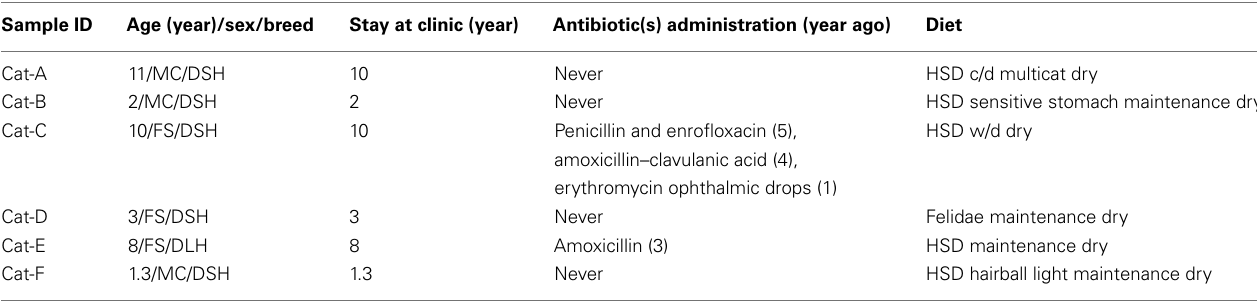
TableA1 | Information on resident cats from the small animal veterinary